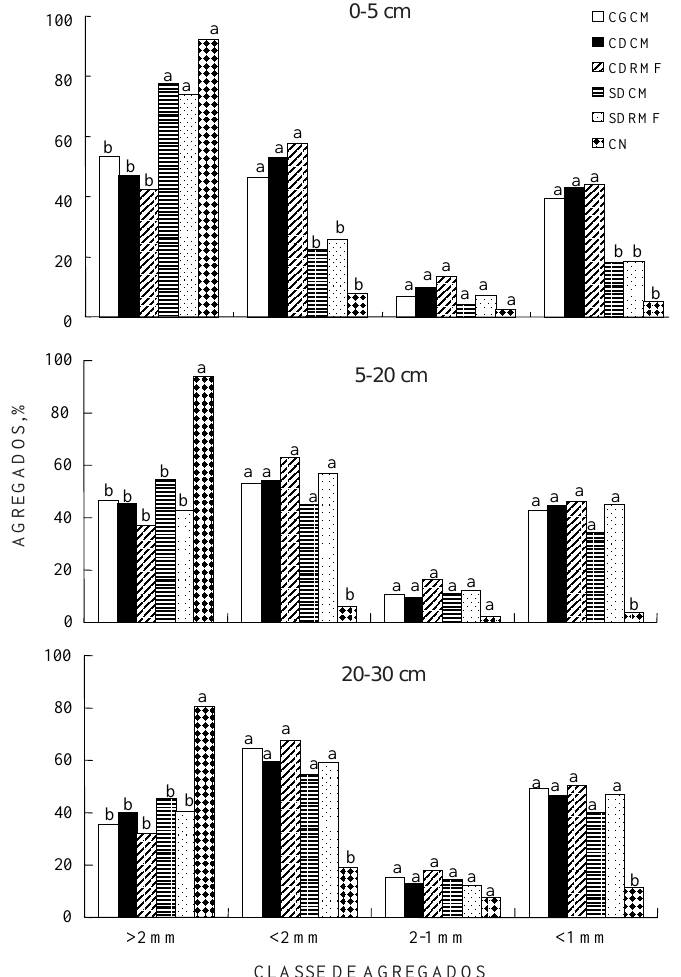
CLASSE DE Figura 1. Distribuição do tamanho dos agregados estáveis em água em Latossolo Vermelho distrófico típico, em diferentes profundidades e sistemas de manejo, Sete Lagoas (MG). Letras acima das barras comparam sistemas de manejo, em diferentes classes de agregados, pelo teste Scott e Knott (P ££ ££ £ 0,05).